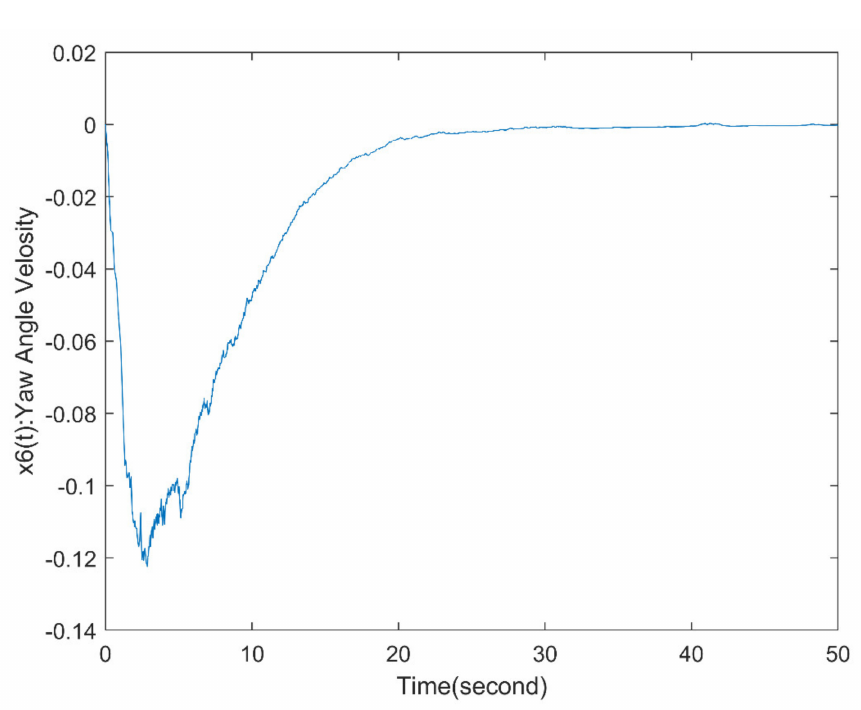
Figure 7. Response of state x 6 ( t )